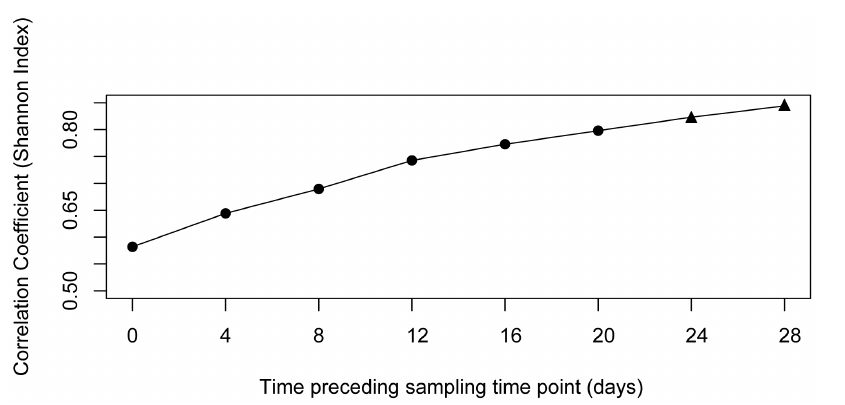
Figure 3. Lag analyses for the correlation between diversity (Shannon Index) and mean temperature integrated over 28 days prior to the sampling event. Day 0 corresponds to the temperature measured at the sampling day representing an immediate response, while day 28 uses the mean temperature of the previous month representing a slower response to temperature shifts. Significant correlations between diversity and temperature are depicted by black triangles.